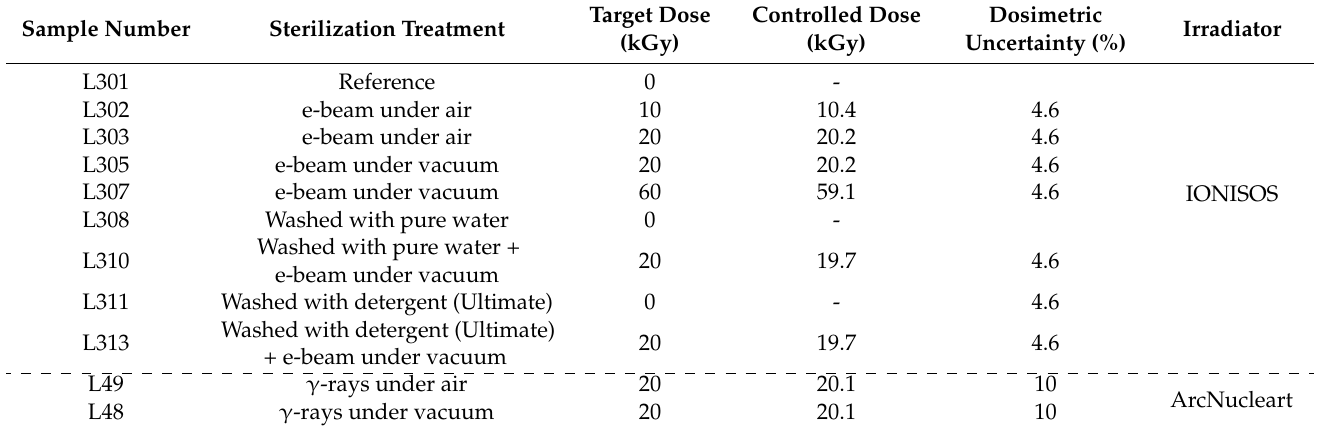
Table 1. Sterilization conditions of the Valmy FFP2 medical mask. NB: L301 corresponds to unsterilized unwashed mask. Sample